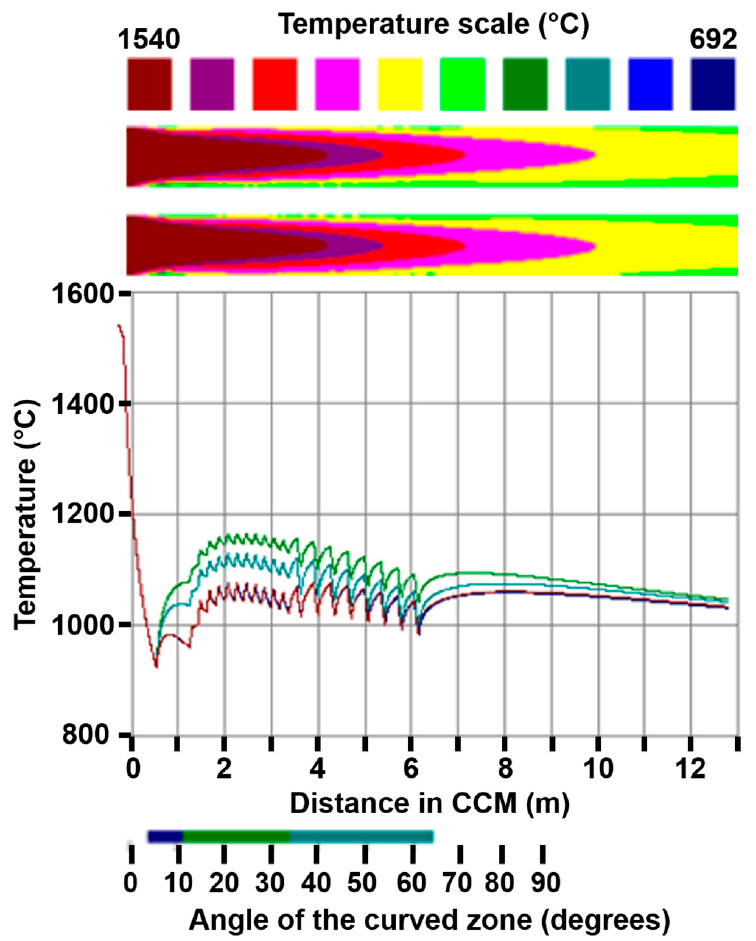
Figure 13. Temperature profiles and surface temperature of a squared billet with no homogeneous heat removal.